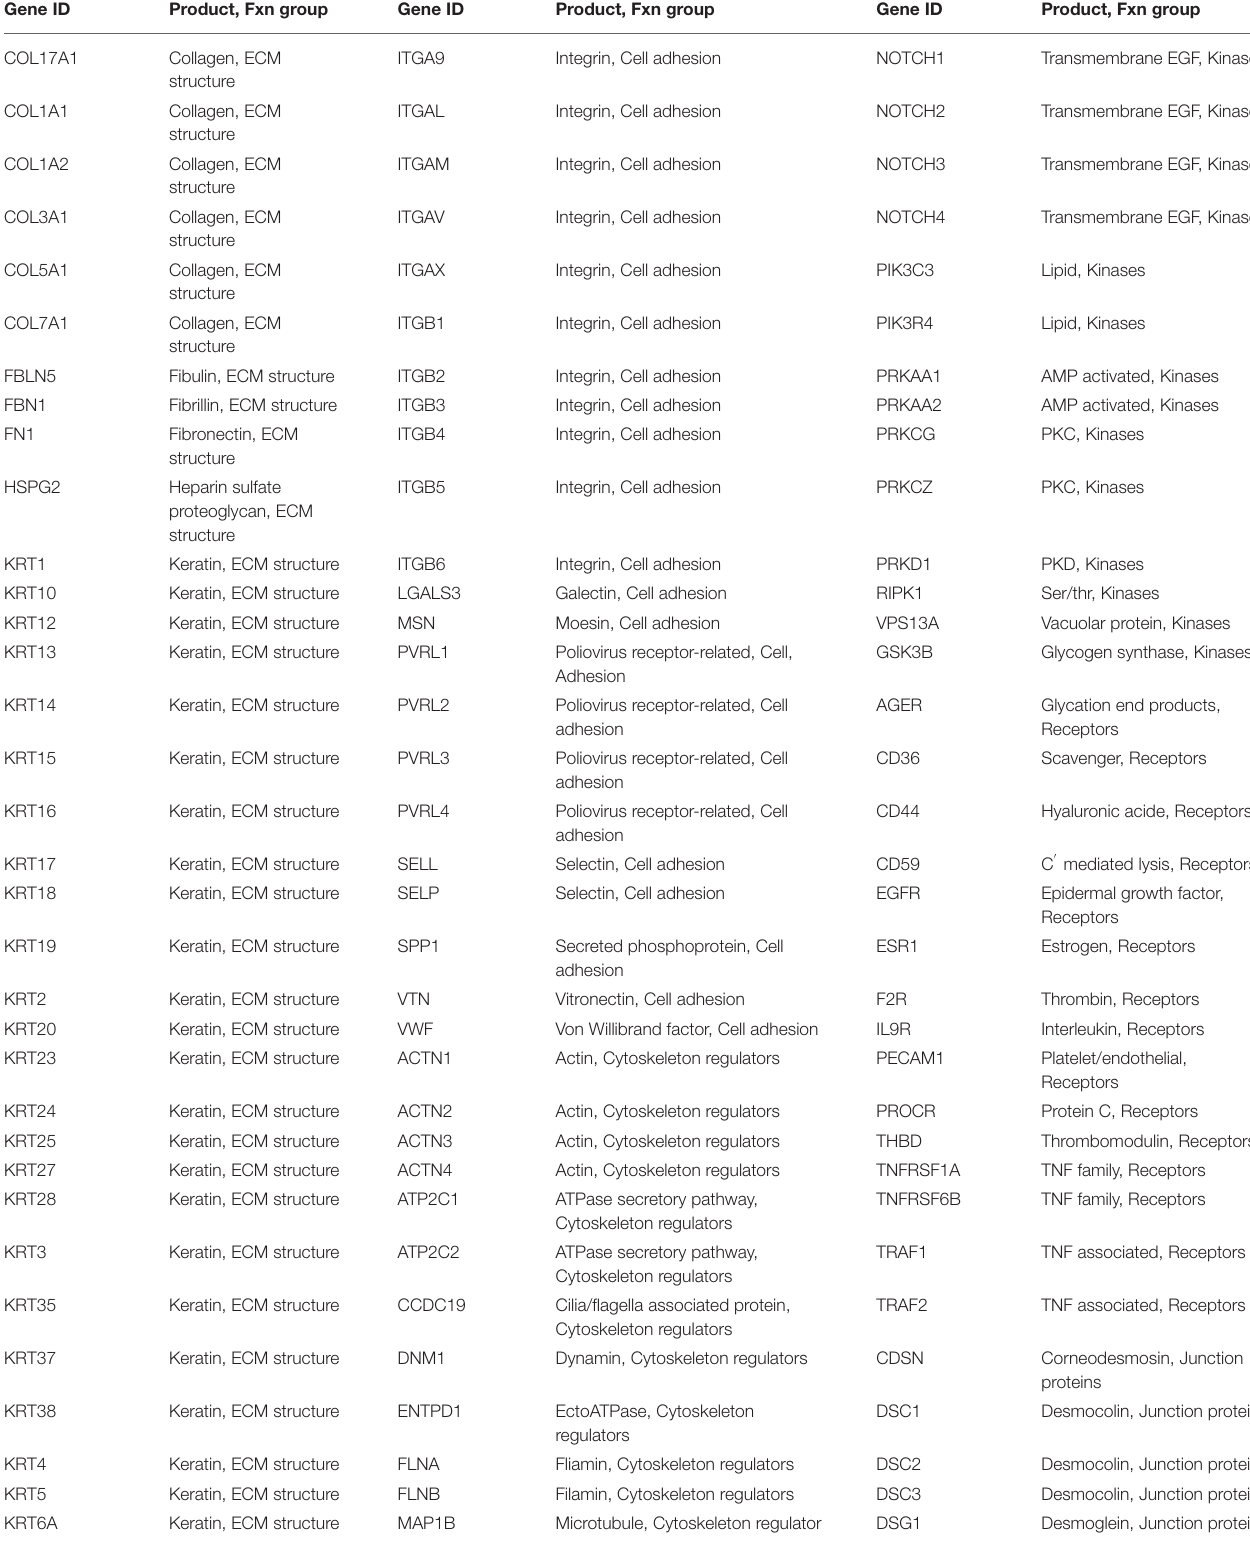
TABLE 2 | Targeted gene for functions of